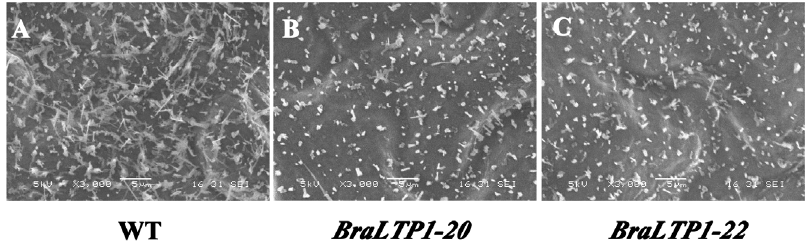
Figure 4. Epicuticular wax and cuticle layer of air-dried adaxial leaf surfaces of wild type (WT), the BraLTP1-20 and BraLTP1-22 overexpressor using scanning electron microscopy. The experiments were repeated for 3 times with at least five plants for each time. (A) Wax crystals on the WT leaf were dense, with high proportion of tubular-like wax crystals. (B and C) Wax crystals are sparsely distributed on BraLTP1-20 and BraLTP1-22 B. napus leaves. Bar=5 m m.